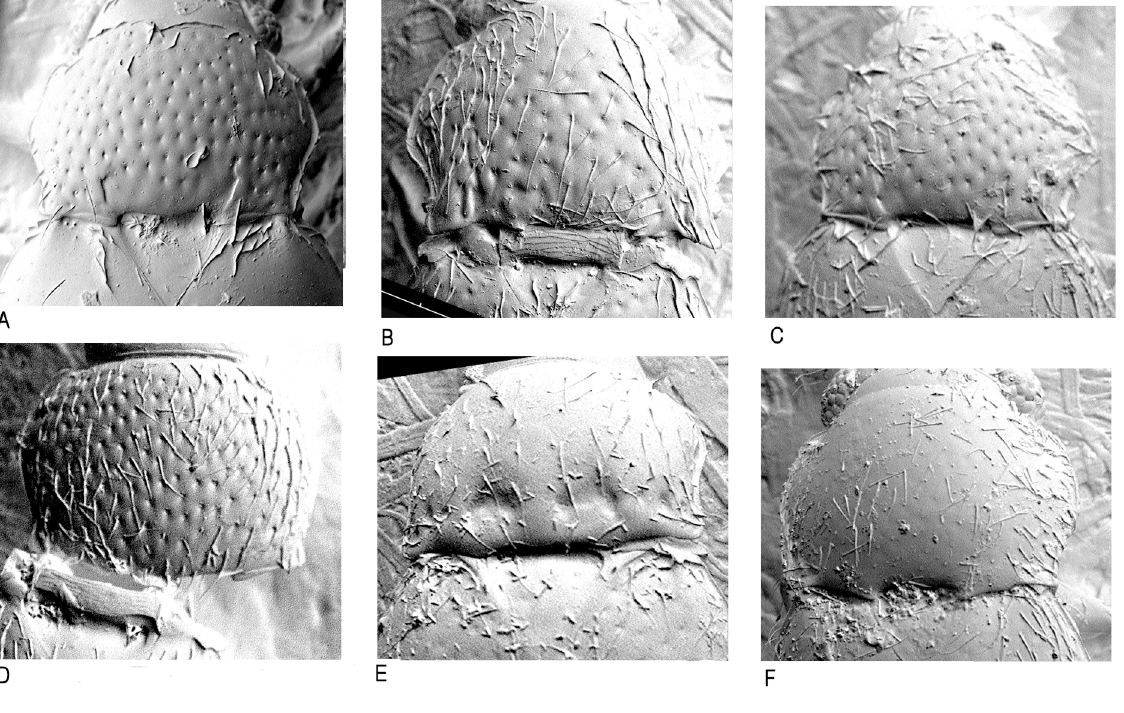
Fig. 7. Cissidium spp., pronota. A . C. globulum sp. nov. ×450. B . C. longum sp. nov. ×590. C . C. marshallae sp. nov. ×580. D . C. pauxillum sp. nov. ×590. E . C. subfoveolatum sp. nov. ×485. F . C. triangulum sp. nov.